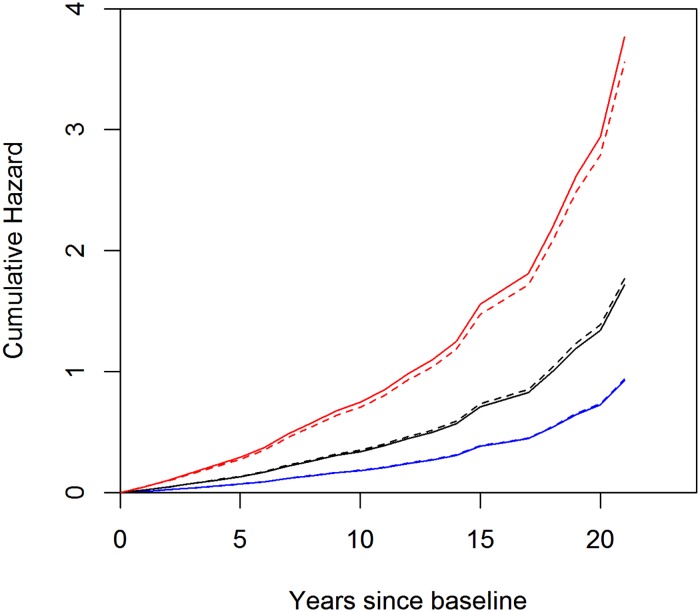
Cumulative hazards of incident AD dementia by APOE ε4 and TOMM40 ‘523-L genotypes in Caucasian Americans.The figure illustrates cumulative hazards of incident AD dementia for representative female Caucasians with mean age and education. The blue solid curve represents cumulative hazard for non-ε4 carriers, the black solid curve for ε4 heterozygotes, and the red solid curve for ε4 homozygotes. Superimposed are the blue dash curve representing cumulative hazards for non-‘523-L carriers, the black dash curve for ‘523-L heterozygotes, and the red dash curve for ‘523-L homozygotes.